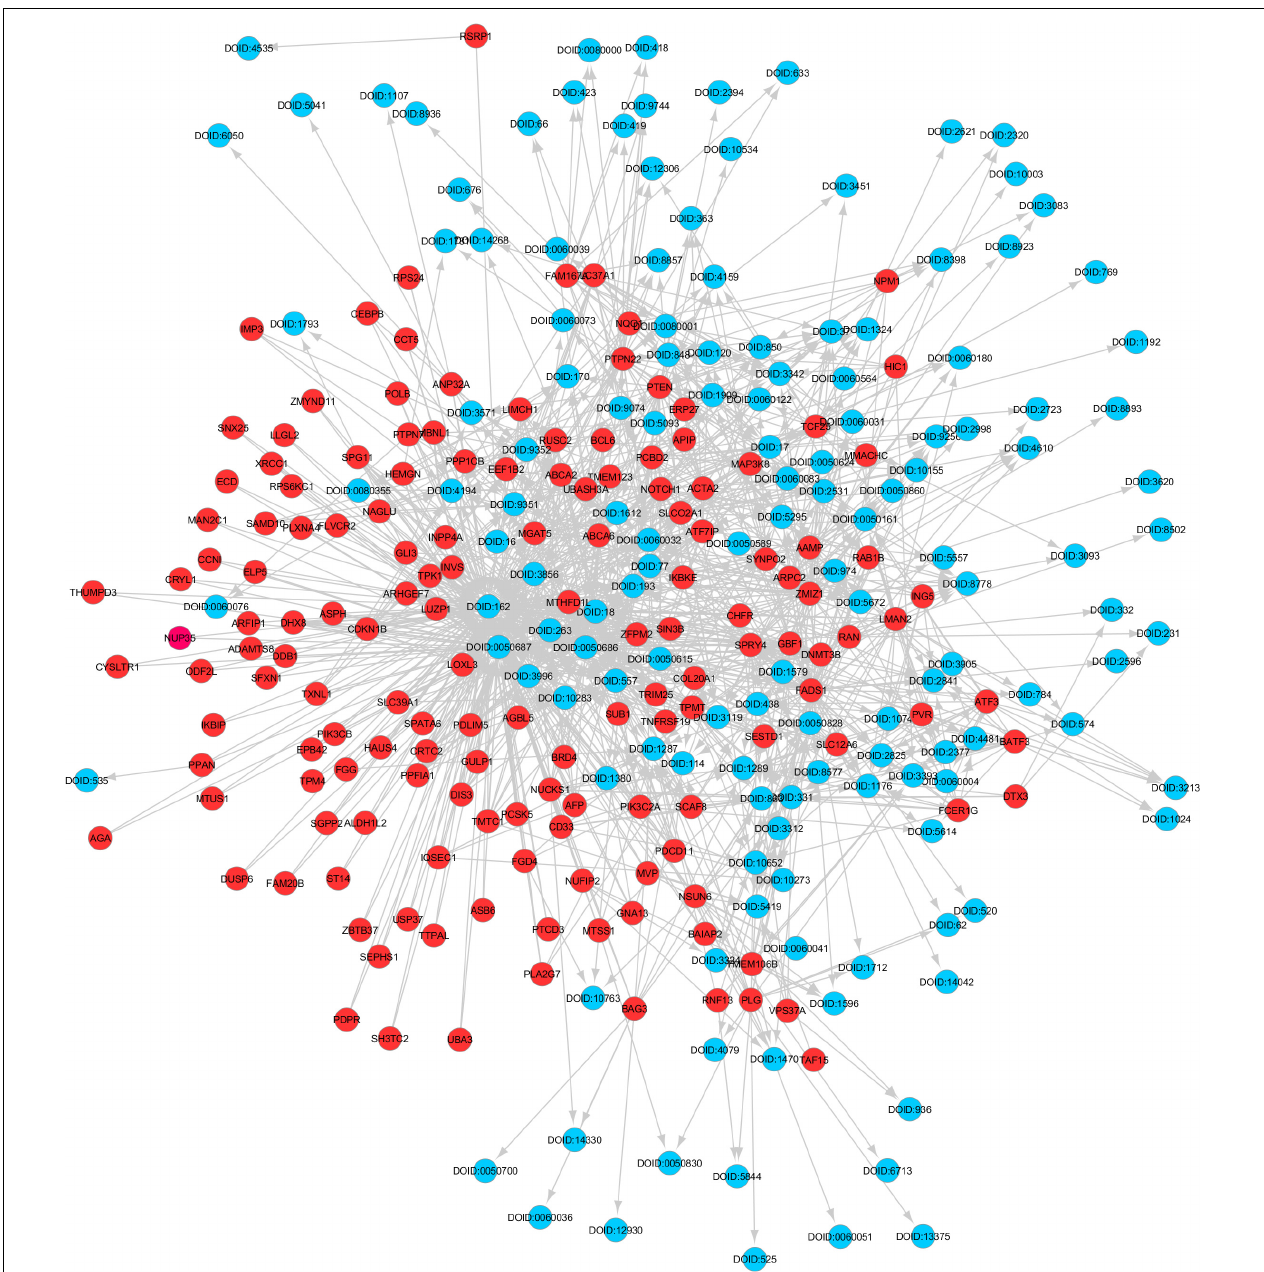
FIGURE 3 | Gene Disease Knowledge Graph constructed from muscle atrophy genes and their associations with diseases identified from the SPOKE database. The red colored circles are the gene nodes and the blue colored circles are disease